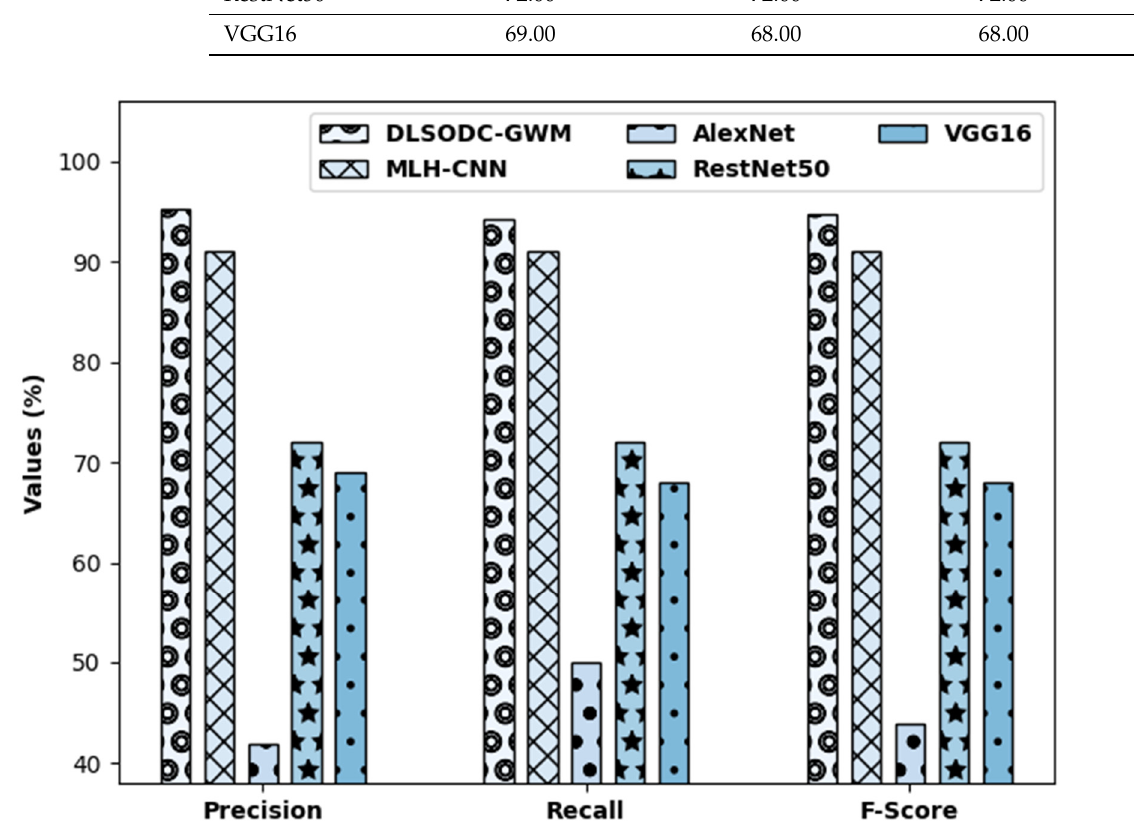
Figure 14. Comparative analysis of DLSODC-GWM technique with recent methods. However, the MLH-CNN approach has resulted in near-optimal prec n , reca l , and F score of 91%, 91%, and 91%, respectively. The presented DLSODC-GWM methodology has accomplished superior performance with prec n , reca l , and F score of 95.23%, 94.29%, and 94.73%,